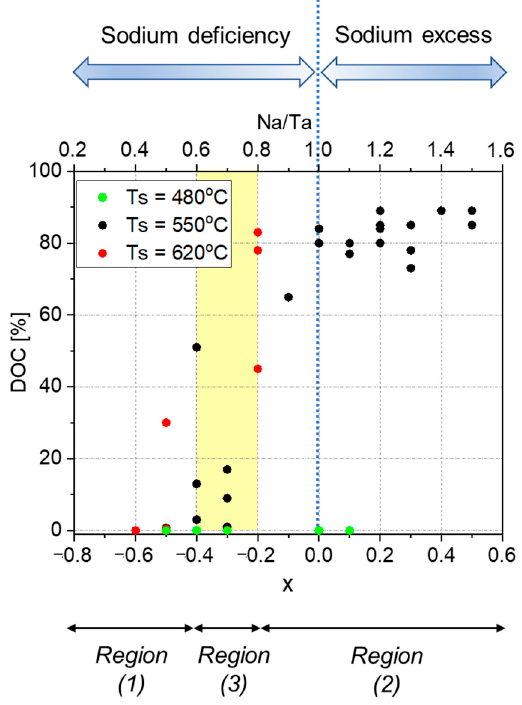
Figure 7. DOC versus x in Na 1+x TaO 3 ± δ (bottom x-axis) and Na/Ta (top x-axis). Data include all the samples deposited in the deposition sessions summarized in Table 1, for a total of forty points ana- lyzed. The area in yellow represents the transition region.